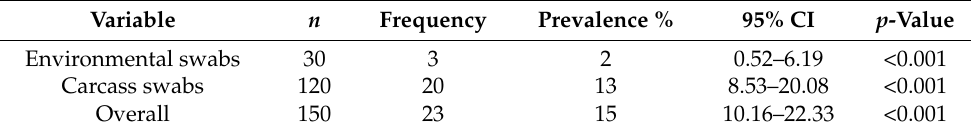
Table 1. Prevalence of Listeria spp. in dressed poultry and environmental samples ( n = 150). Variable n Frequency Prevalence % 95% CI p -Value Environmental swabs